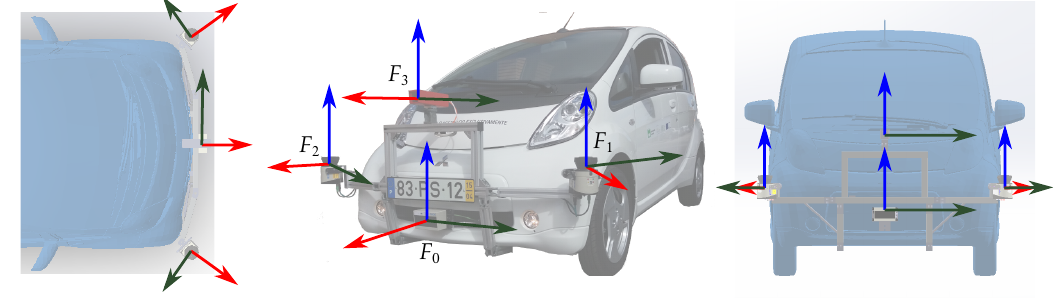
Figure 5. Example of four sensors in ATLASCAR2